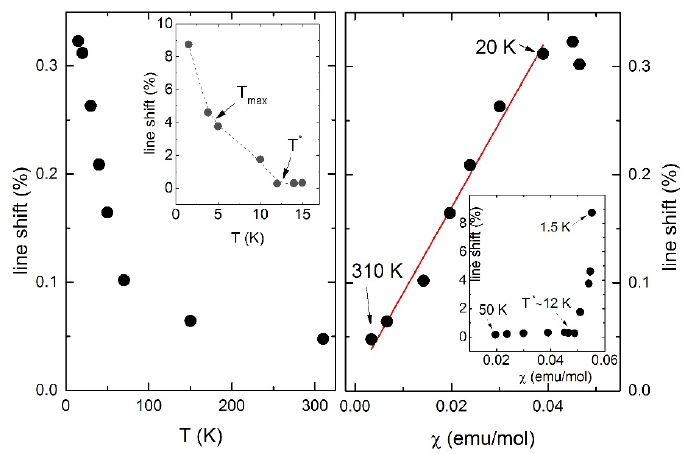
Figure 9. ( Left ) Temperature dependence of 7 Li NMR line shift. Inset: the low-temperature part of the K ( T ), line is a guide for eye. ( Right ) local spin susceptibility versus bulk magnetic susceptibility. Inset shows low-temperature region.